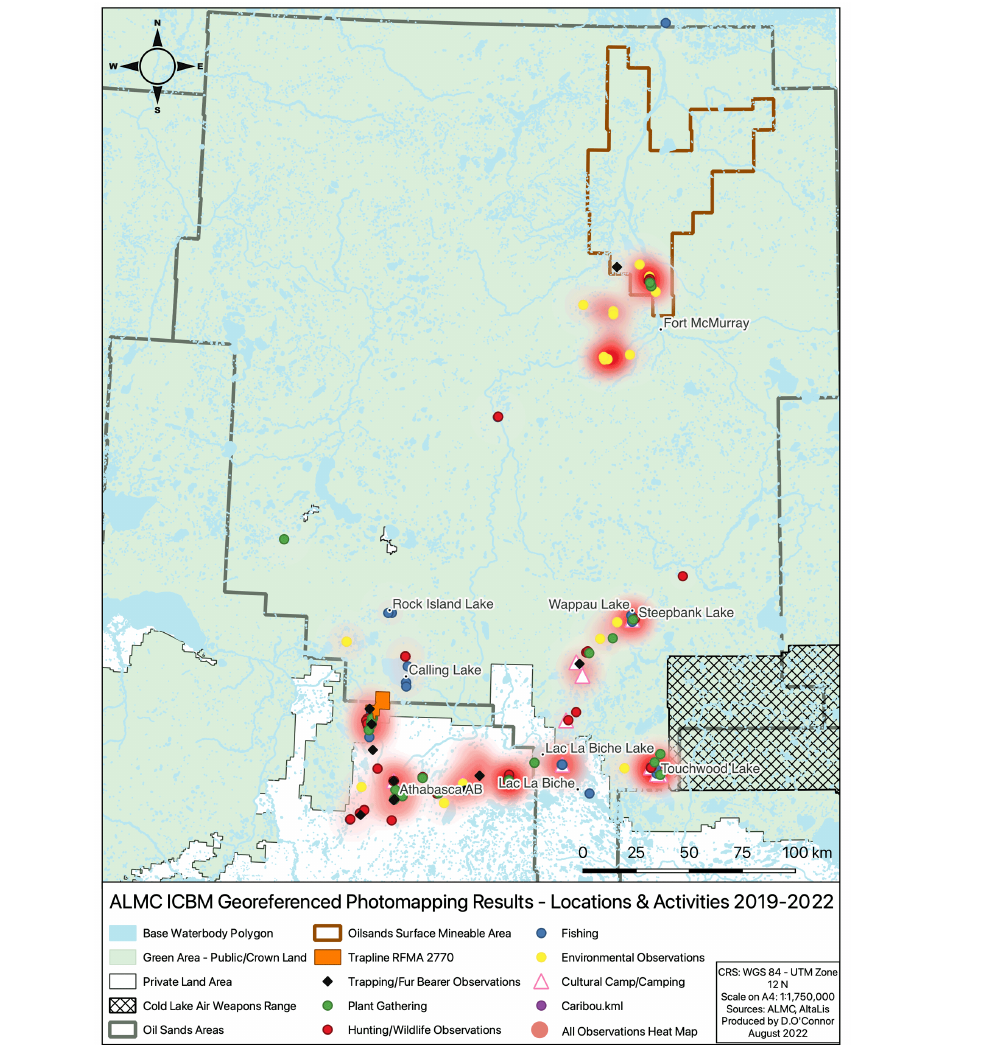
Fig. 1. Results of Athabasca Landing Métis Community’s (ALMC) photomapping method of documenting resource and harvesting sites, 2019–